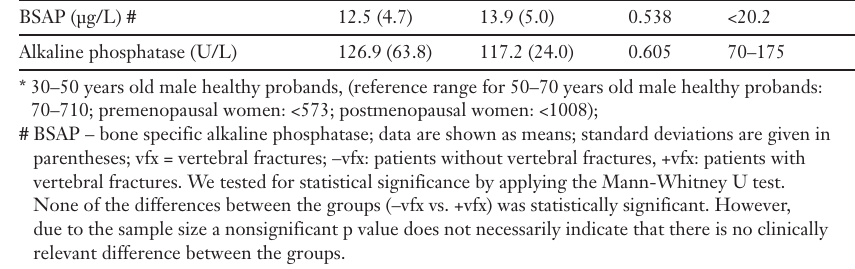
Markers of bone